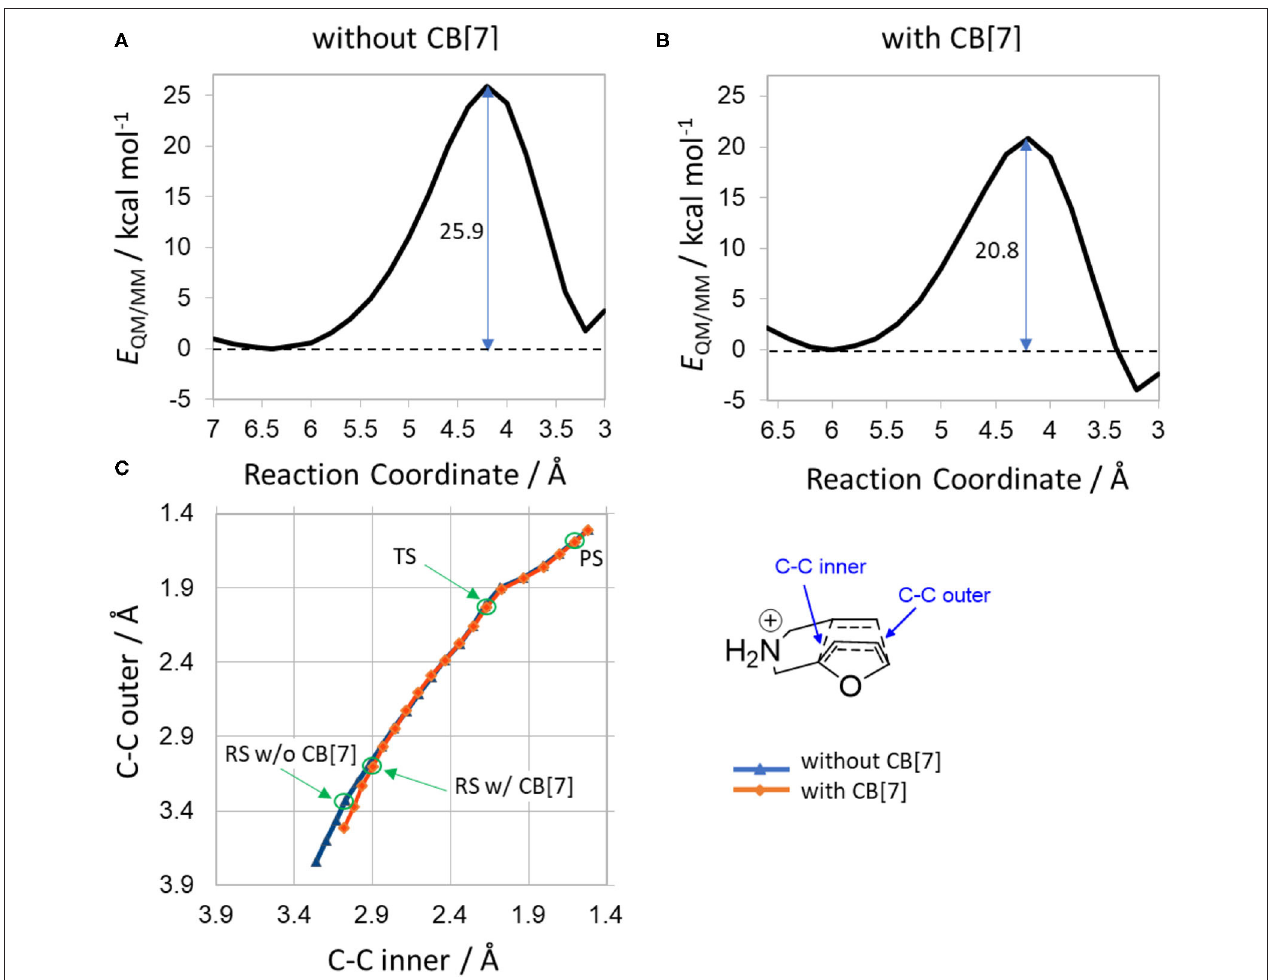
FIGURE 4 | Results of QM/MM potential energy scans (A) without CB[7] and (B) with CB[7]. The reaction coordinate is the sum of the distances of C-C inner and C-C outer bonds. Reaction barriers are shown in kcal/mol, indicated by vertical arrows in the profiles. (C) Change in biased distances along the scan (red/blue symbol with/without CB[7]). Bond definitions are highlighted in the inset. Note that these bonds are not individually constrained, but their